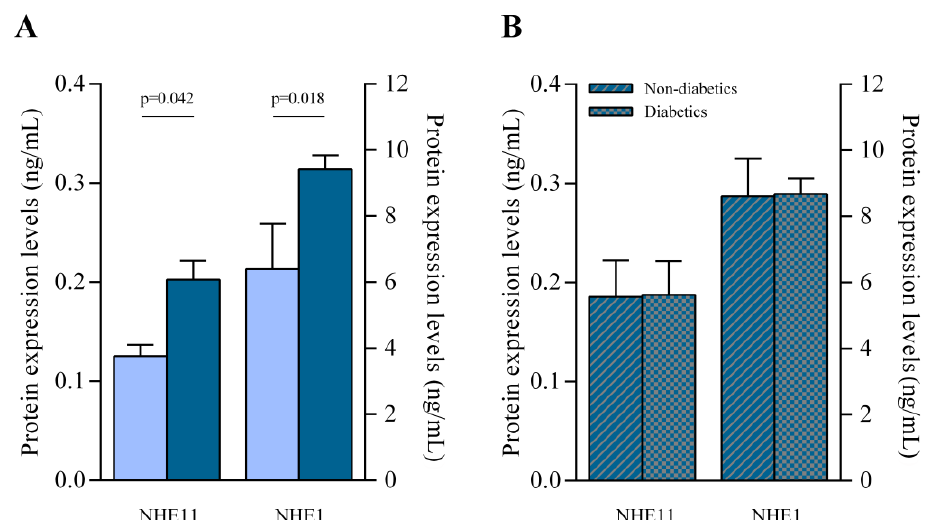
Figure 2. NHE11 and NHE1 protein concentration in human heart failure (HF) hearts. ( A ) NHE11 and NHE1 protein levels in control versus HF samples. ( B ) NHE11 and NHE1 protein levels in HF without type 2 diabetes versus HF with type 2 diabetes. Bars represent mean ± SEM values. Controls subjects (n = 10; light blue) and heart failure patients (n = 70; dark blue). HF without type 2 diabetes (dark blue and grey stripes), HF with type 2 diabetes (dark blue and grey squares).